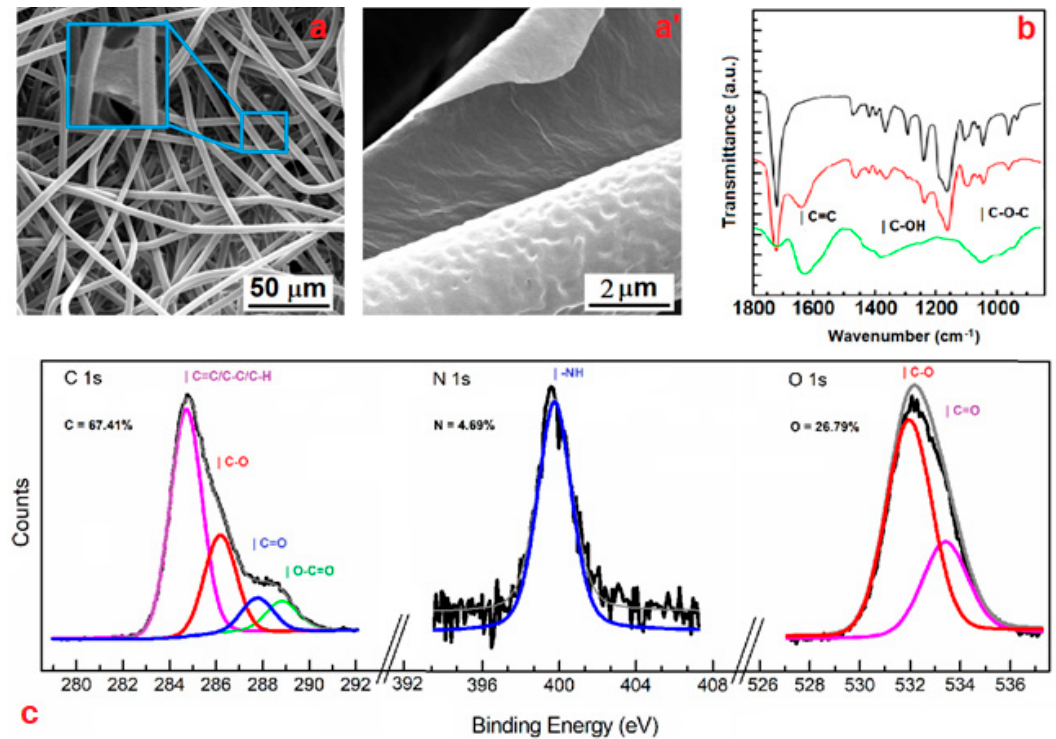
Figure 1. SEM analysis ( a–a’ ) of the GO–PCL sample. Fourier transform infrared (FTIR) spectra of PCL (black), GO–PCL (red), and GO (green) in the region within 1800–800 cm − 1 ( b ). X-ray photoelectron spectroscopy (XPS) spectrum of GO–PCL: experimental spectrum (black), composite spectrum (grey), and deconvolution peaks are showed as colored curves ( c ).